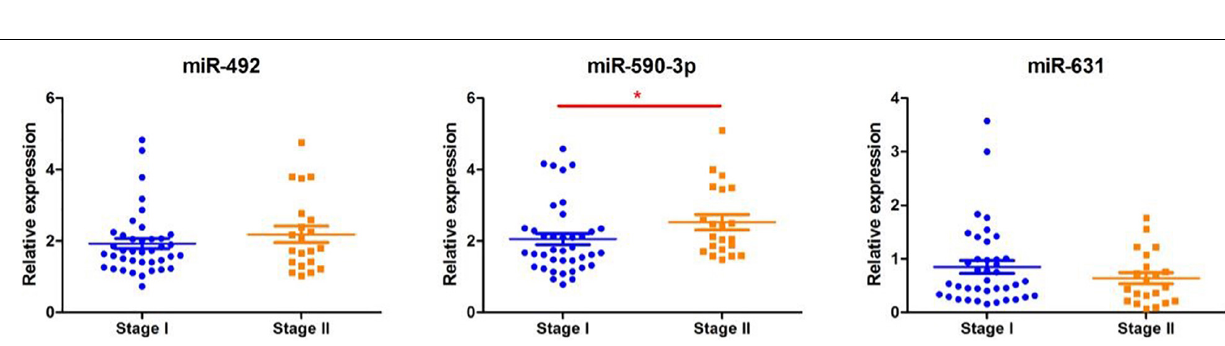
Frontiers in Genetics |